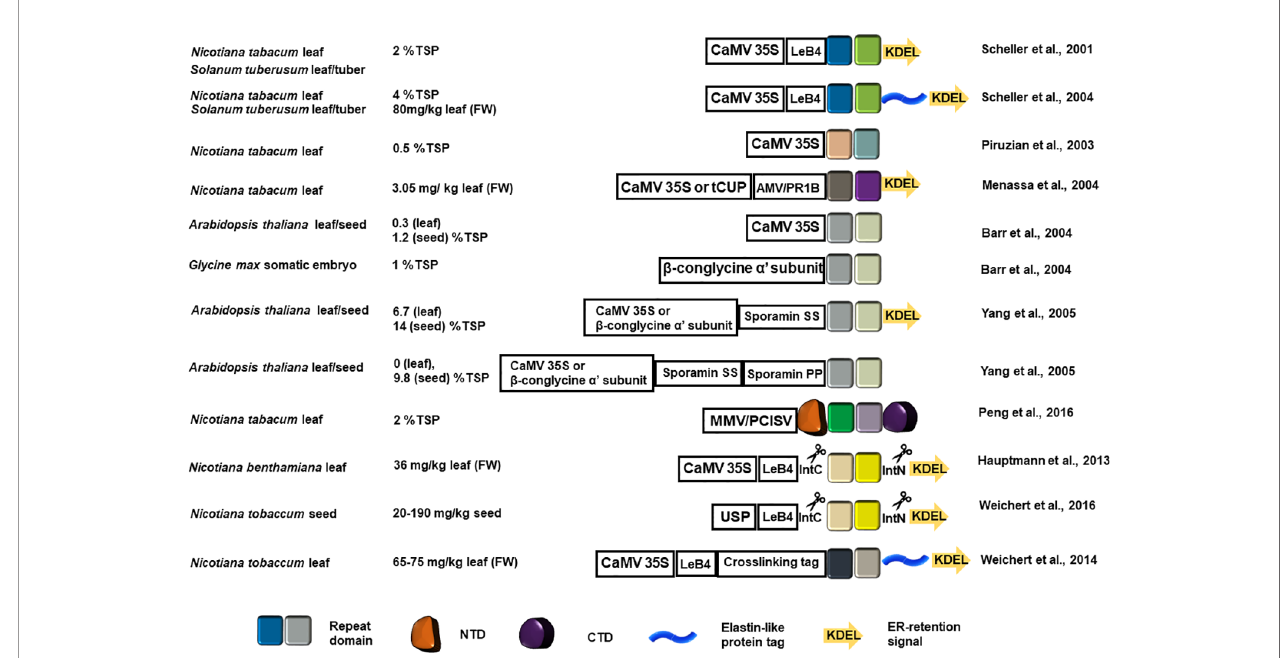
FIGURE 2 | Schematicrepresentation of the recombinant spidroin constructs introduced into a plant hostsystem and the estimated yield. The colored squares represent the designed recombinant repeat blocks. Color variation indicates repeat block sequence variation ineach application.The NTD andCTD are represented as in Figure 1 . The elastin-likeproteintag isshown as a blue helix and the ER retention signalis shownas a coloredarrow. CaMV 35S, Cauli fl ower mosaicvirus promoter;AMV, Alfalfa mosaicvirus translational enhancer;PR1b, tobacco secretory signal peptide PR1b; MMV, Mirabilis mosaicvirus fulllength promoter;PCISV, Peanut chlorotic streak caulimovirus fulllength promoter;USP, unknown seedsprotein promoter;LeB4, LeB4 signal peptide; IntN, intein N-terminus; IntC, intein